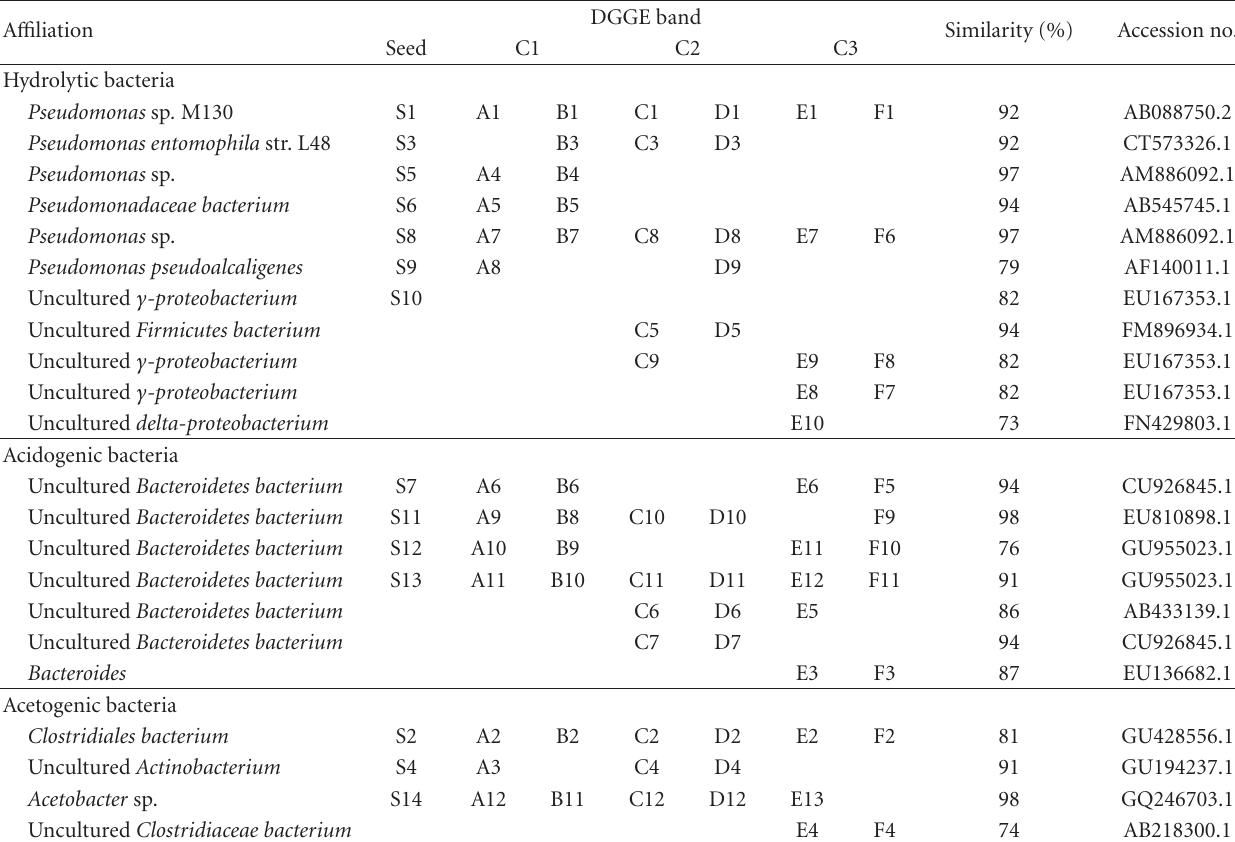
Table 2: The partial 16S rRNA gene sequences of EUB domain and organism with the best-matching sequences determined by BLAST searches.